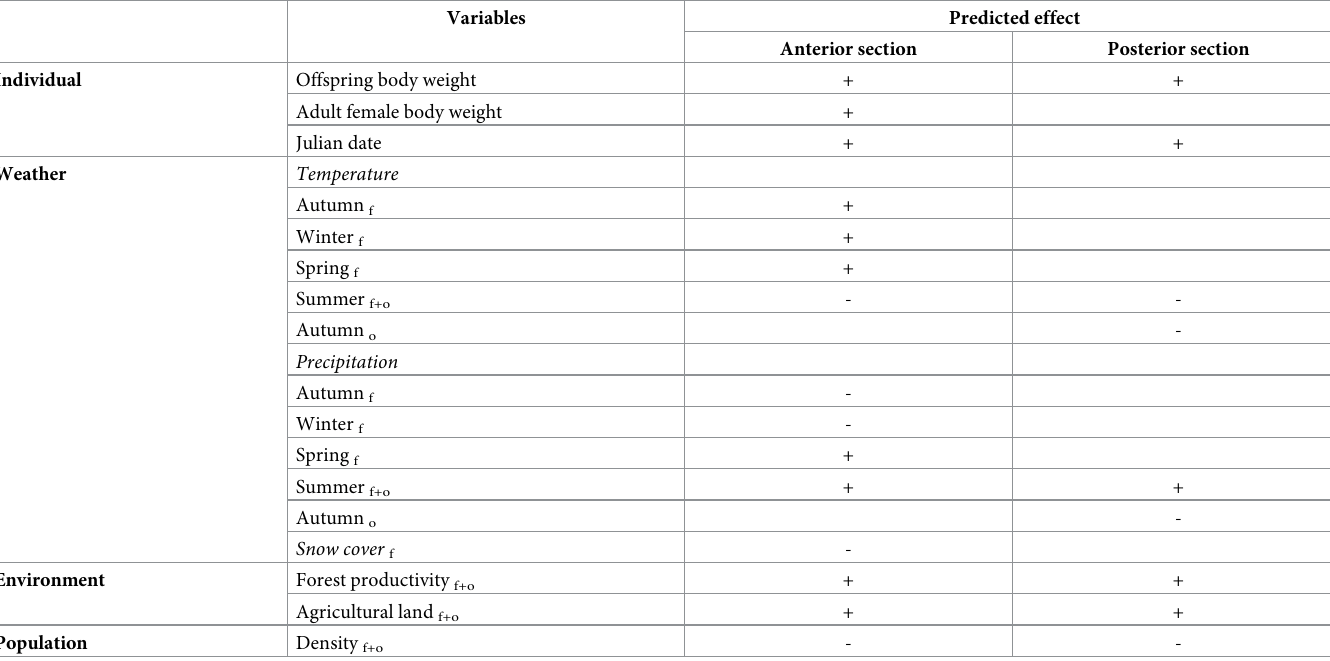
Table 1. Predicted effects on the growth of the anterior and posterior sections of